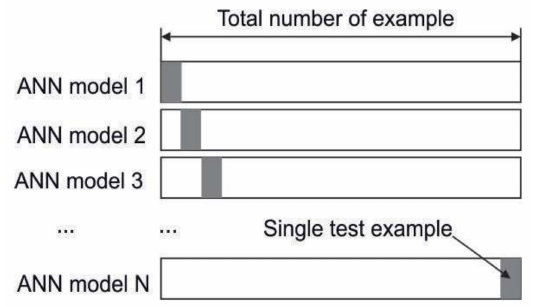
Figure 11. Leave-one-out Cross Validation in ANN